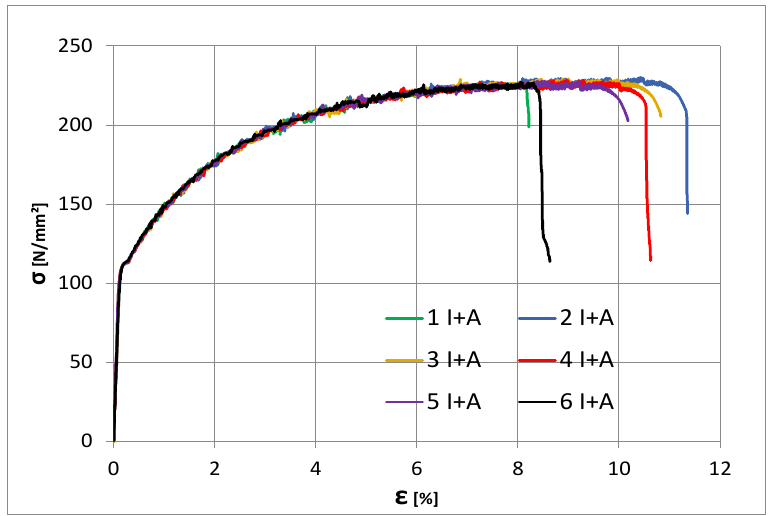
Figure 9. Tensile test curves.